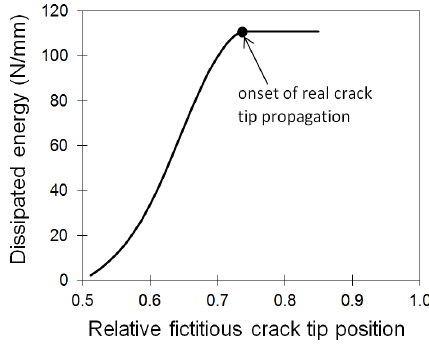
Figure 15. Dissipated energy per unit of fictitious crack surface versus the relative crack tip